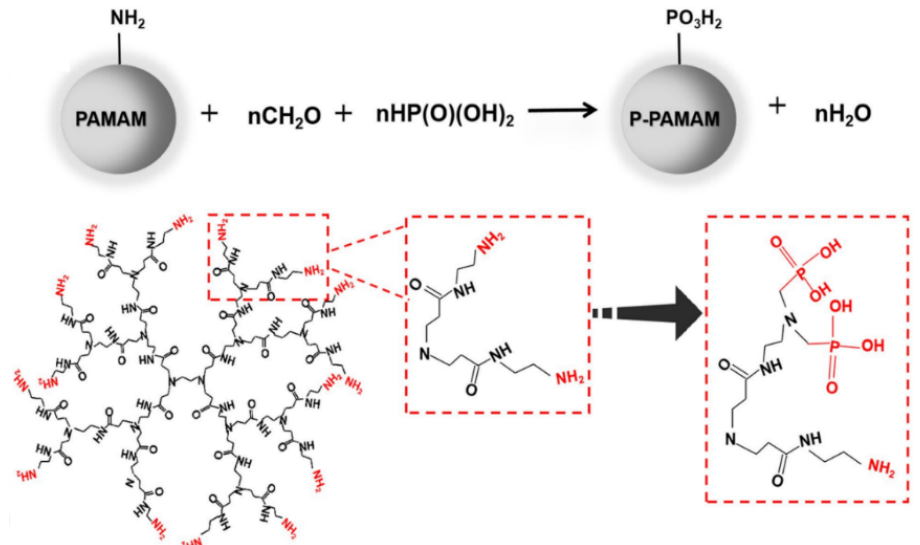
Figure 19. Synthesized mechanism of PAMAM-PO 3 H 2 via the Mannich-type reaction Reproduced under permission from [208]. Copyright: The Author(s).